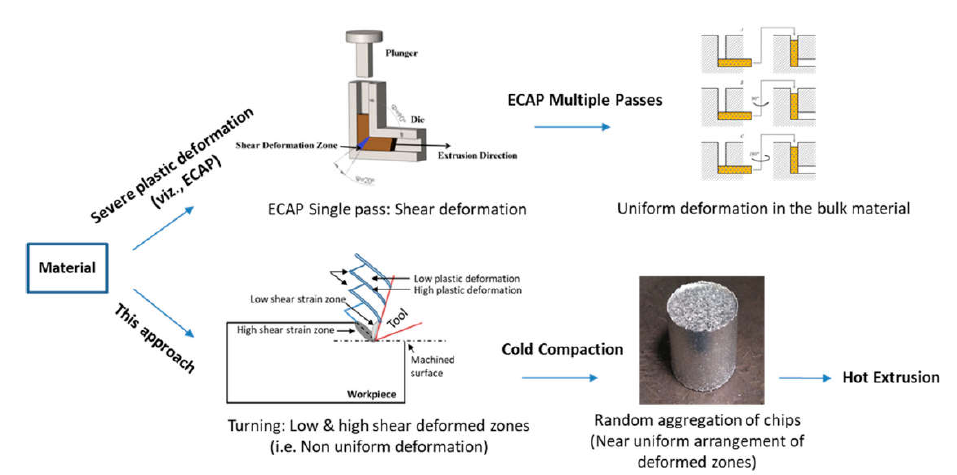
Figure 1. Comparison between ECAP as an existing SPD technique and the newly-explored TID processing method as a new SPD technique [18].